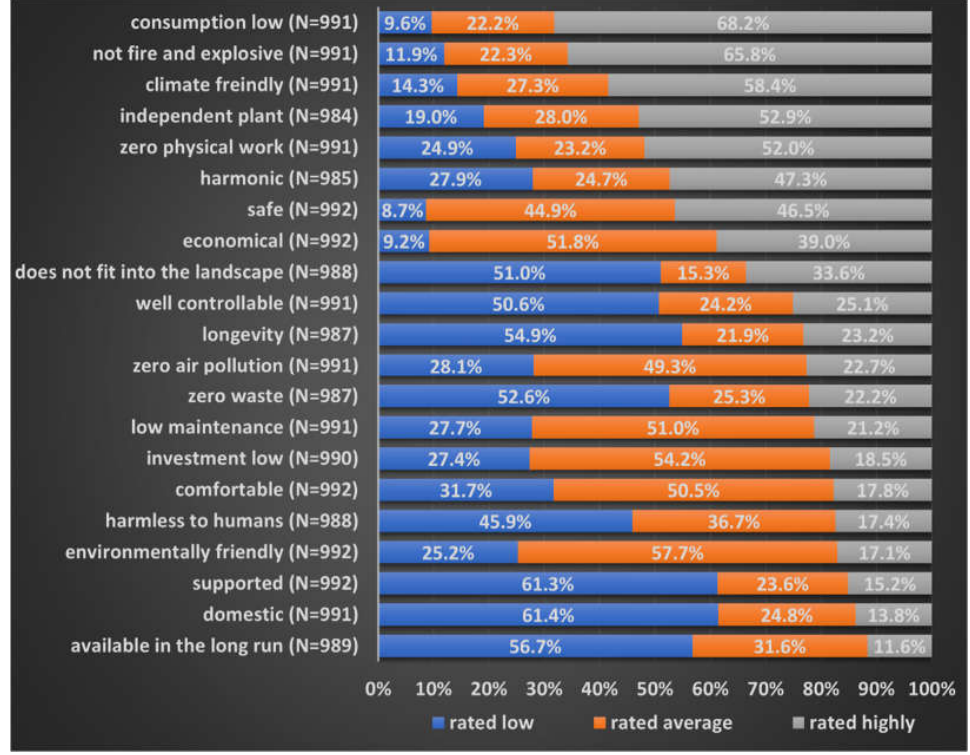
Figure A2. Rating of aspects concerning heating energy generation. Compiled by the authors.